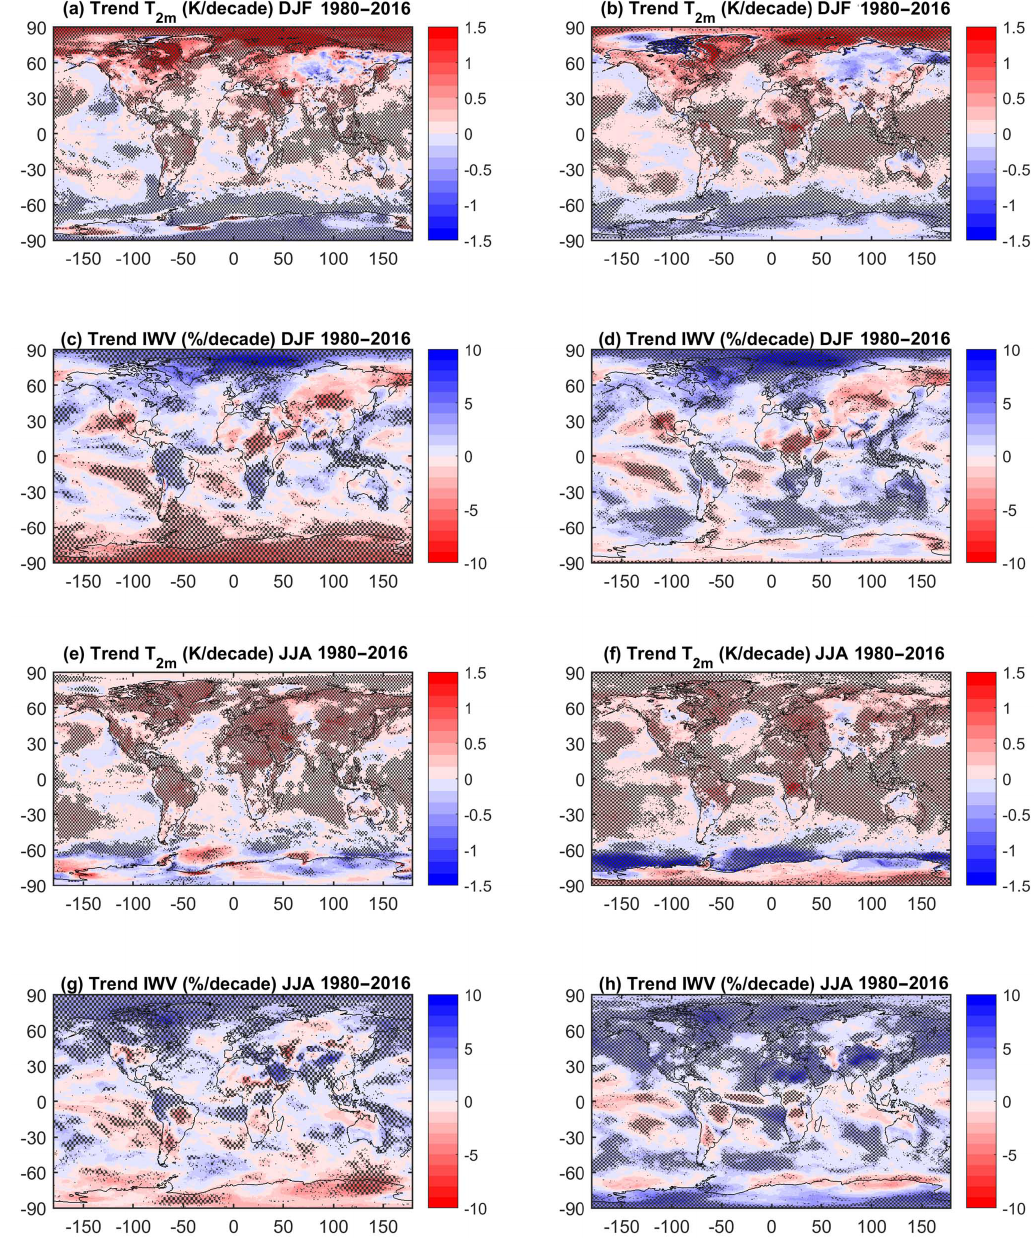
Figure 8. Seasonal trends in Tm and IWV for the 1980 to 2016 period for (a, c, e, g) ERA-Interim and (b, d, f, h)